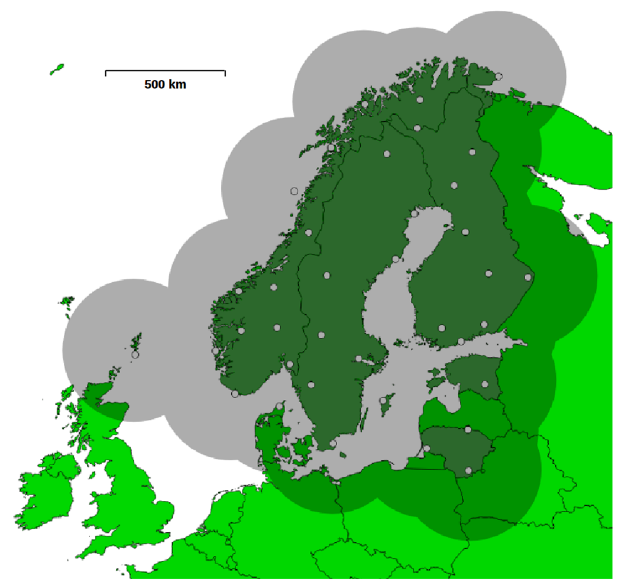
Figure 2. The LLS sensor locations (white dots) and coverage (grey circular areas) as of the year